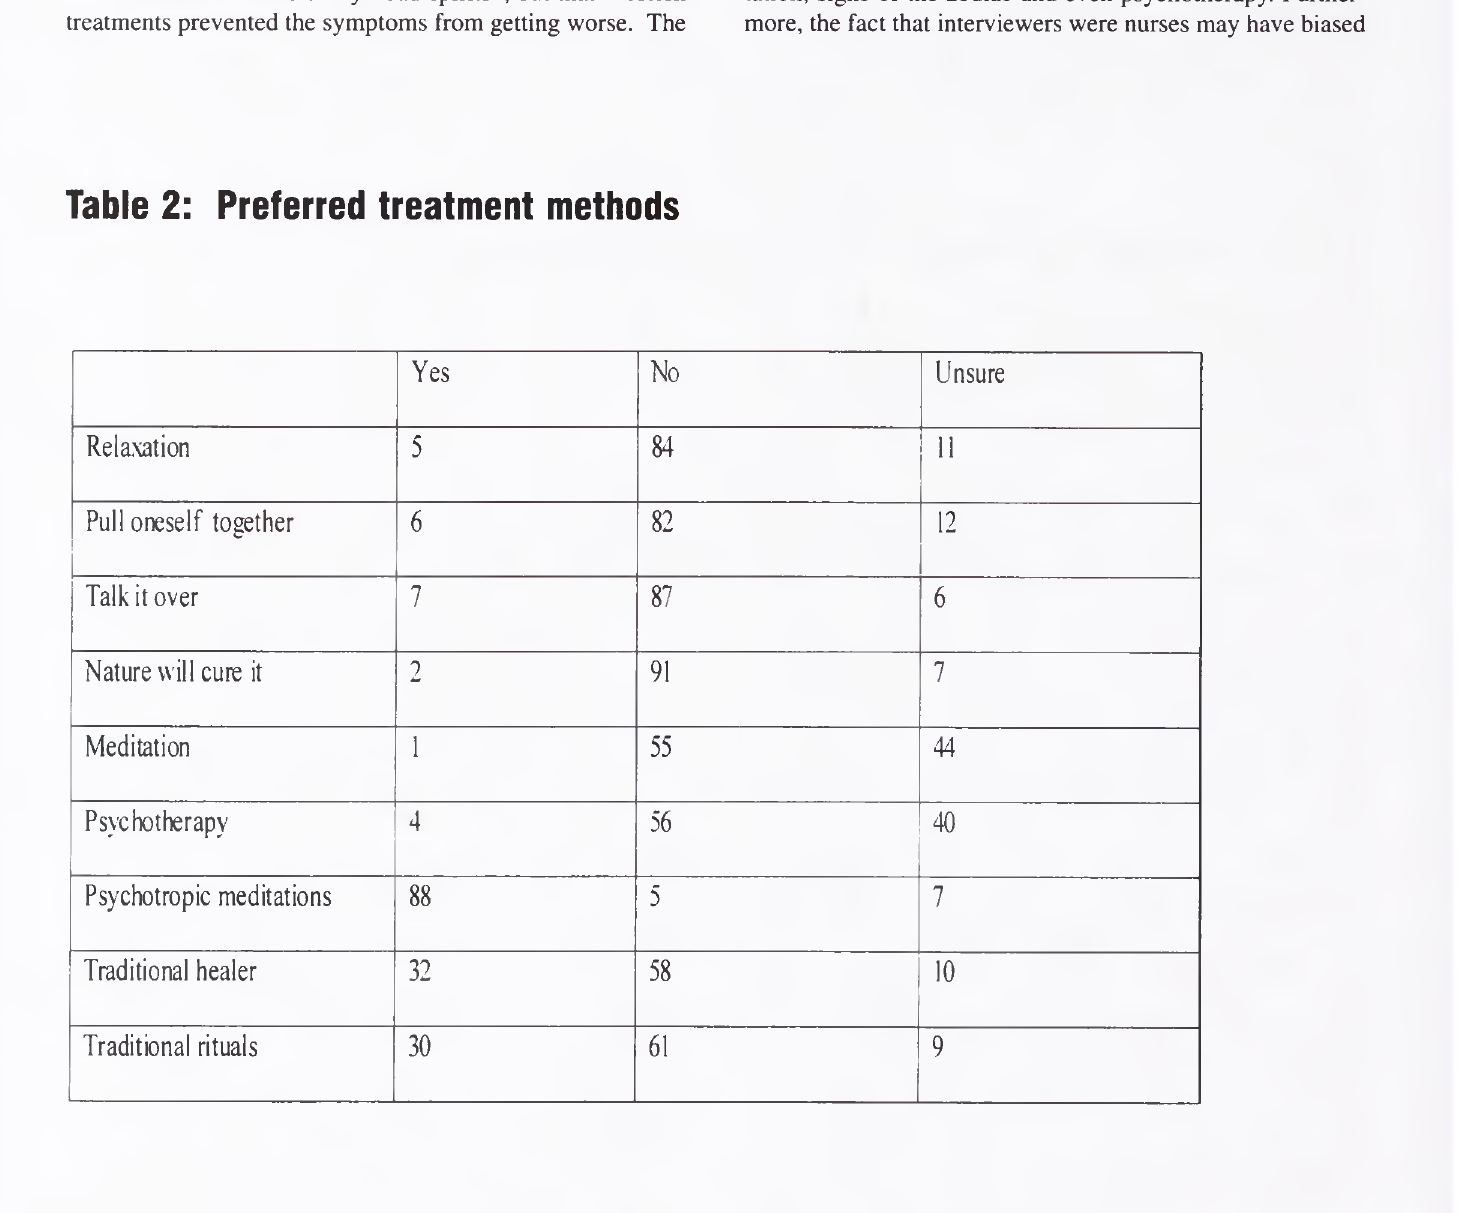
Preferred treatment